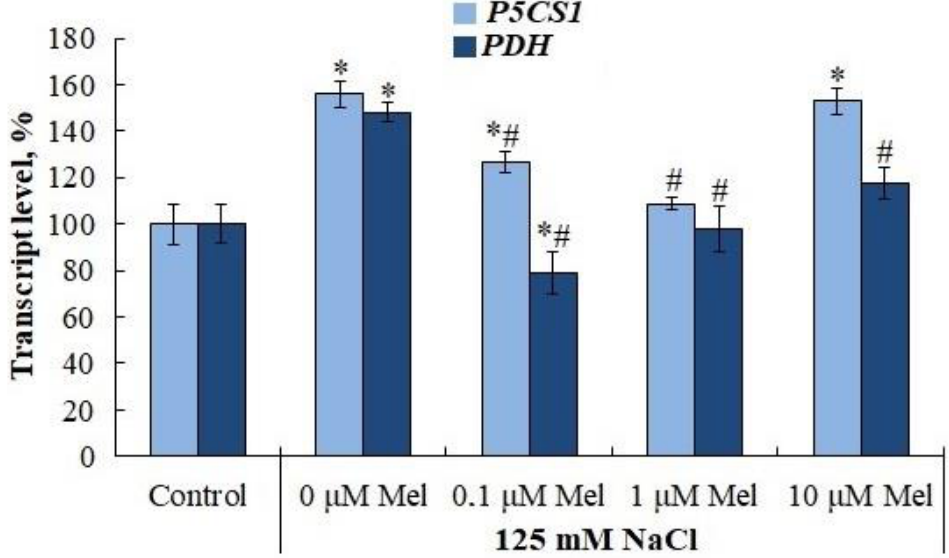
Figure 8. Influence of melatonin and chloride salinity on the level of transcripts of the key genes of biosynthesis ( P5CS1 ) and degradation ( PDH ) of proline in Solanum tuberosum leaves (% of the control). Asterisks (*) indicate significant differences from the control variant and the «#» indicates significant differences from the «125 mM NaCl» variant ( p < 0.05).